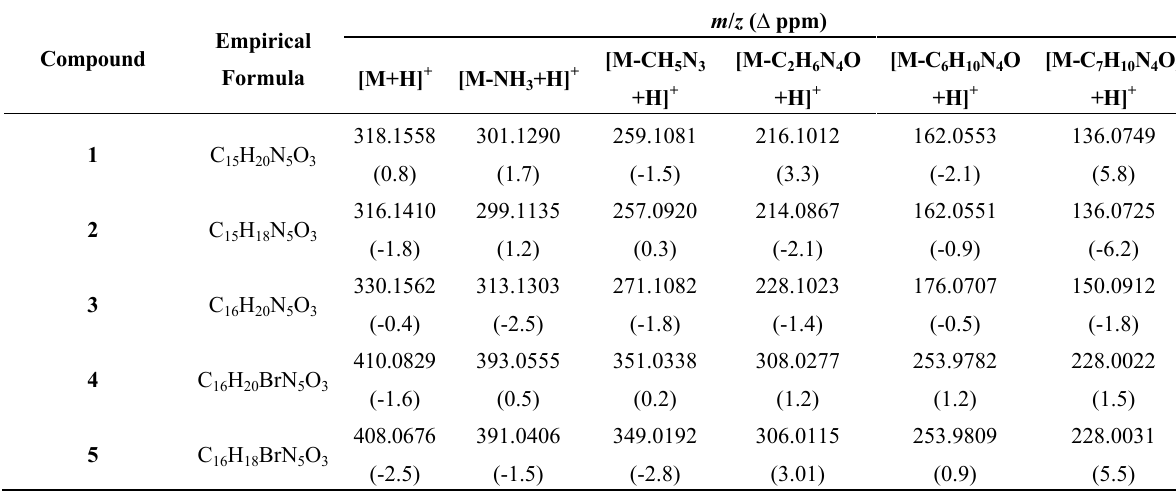
Table 1. Pseudo-molecular ions and characteristic fragments observed in ESI-(+) of compounds 1 - 5